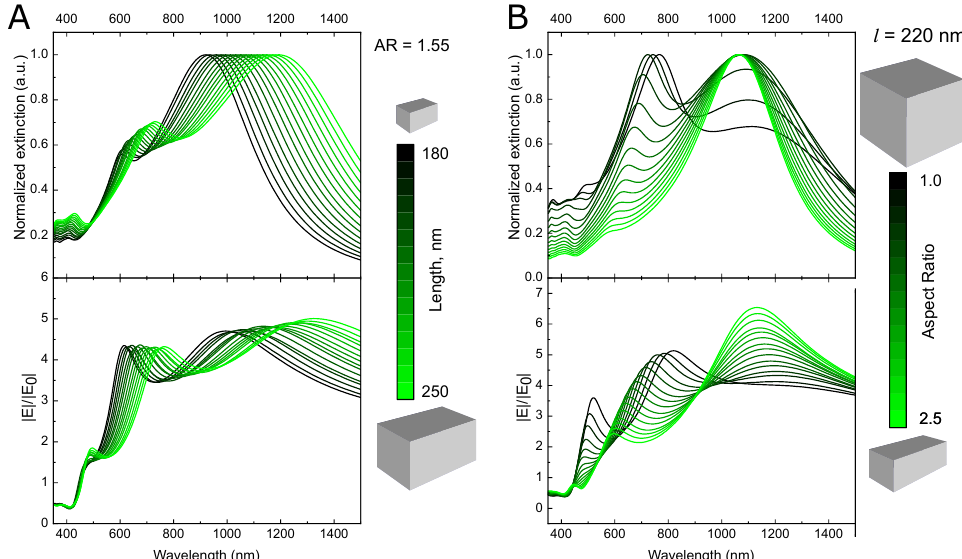
Figure 2. Spectral tunability of Ag nanobar’s LSPR modes. Normalized extinction spectra (top) and electric field enhancement (bottom) for the Ag nanobar of various lengths and the constant aspect ratio of 1.55 ( A ) and various aspect ratios at the constant particle length of 220 nm ( B